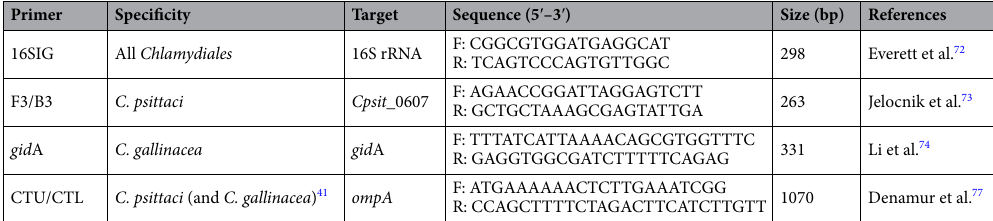
Table 4. Oligonucleotide primers used to determine chlamydial prevalence and C. psittaci